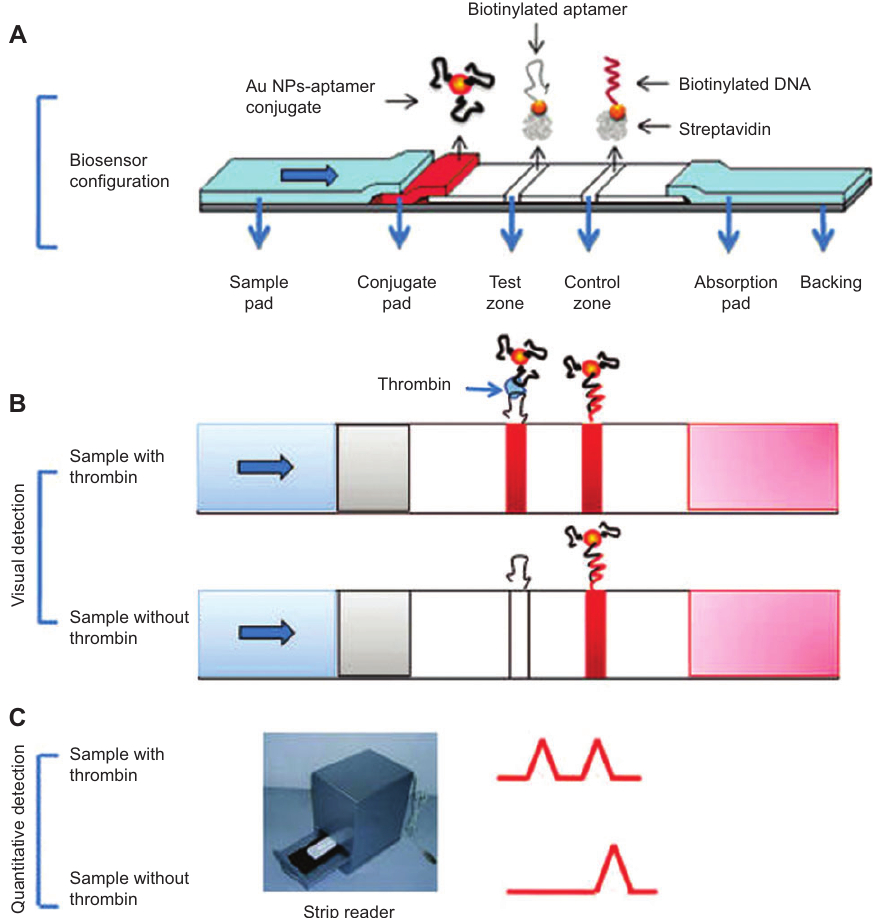
Figure 14 Schematic illustration of the configuration and measurement principle of the aptamer-based strip biosensor. (A) Configuration of the biosensor. (B) The principle of visual detection in the presence and absence of thrombin. (C) Quantitative detection with a portable strip reader. From Ref. [114] .